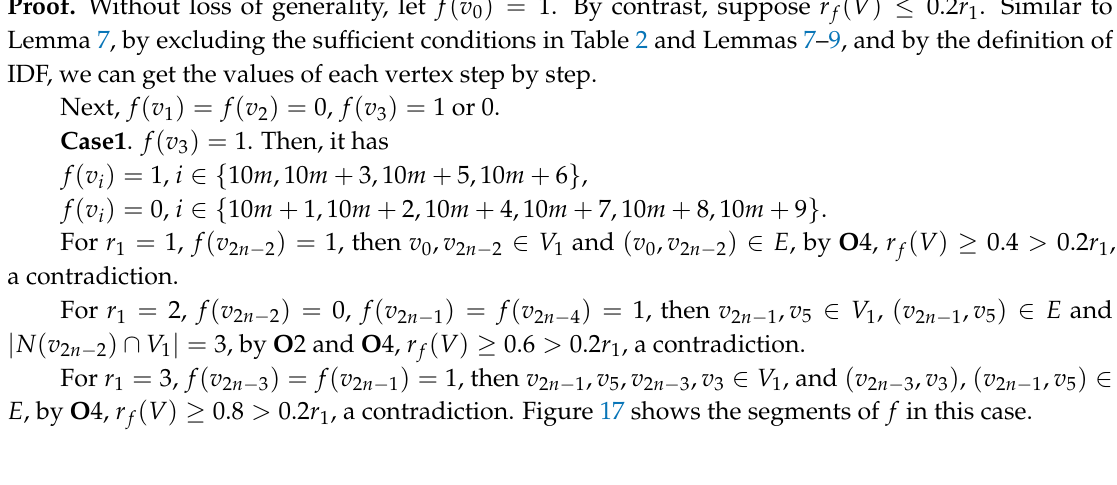
Figure 16. Segment of f in Lemma 9.